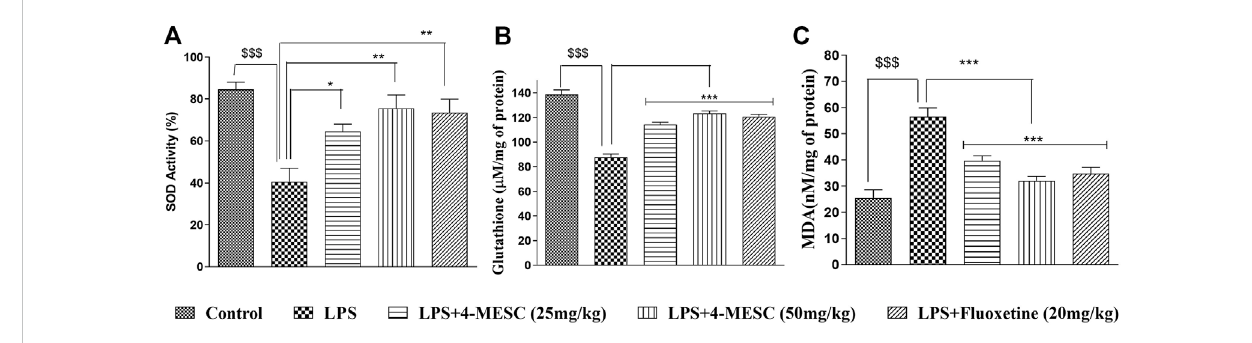
FIGURE 5 4-MESC reduces the LPS-induced oxidative stress. (A) Superoxide activity is evaluated with or without LPS and LPS along with 4-MESC and fl uoxetine taken as a positive control. (B) Glutathione levels were estimated after the LPS treatment and along with 4-MESC. (C) Lipid peroxidation (MDA) wasalsocheckedaftertreatmentwithLPSandinthepresenceof4-MESC.Datawererepresentedasmean±SDand* p < 0.05,**0.05 < p < 0.01,and*** 0.01 < p < 0.001 were considered signi fi cant compared to the LPS